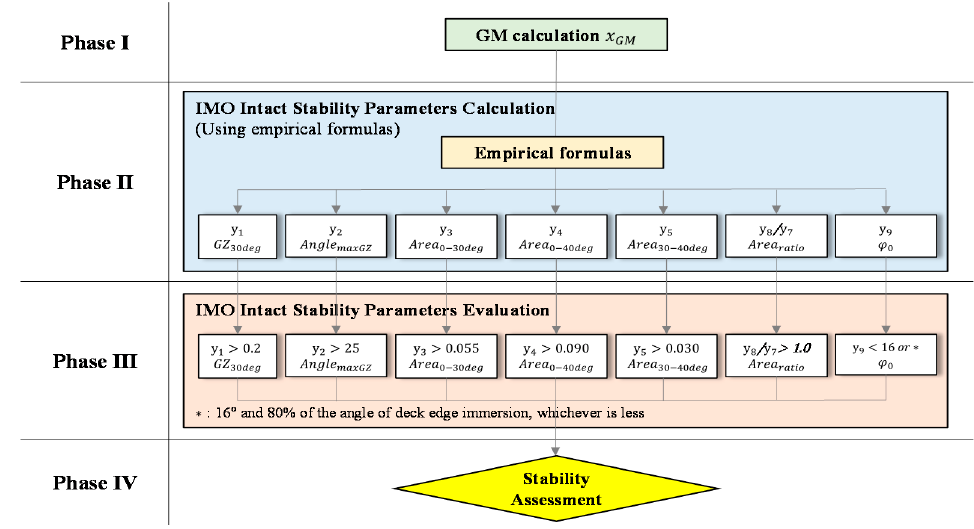
Figure 4. Concept of SEMIS.